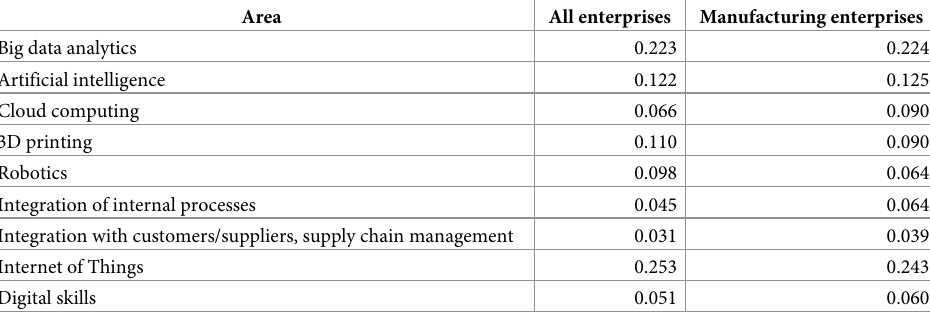
Table 9. Total values of weights for individual dimensions of digital maturity of